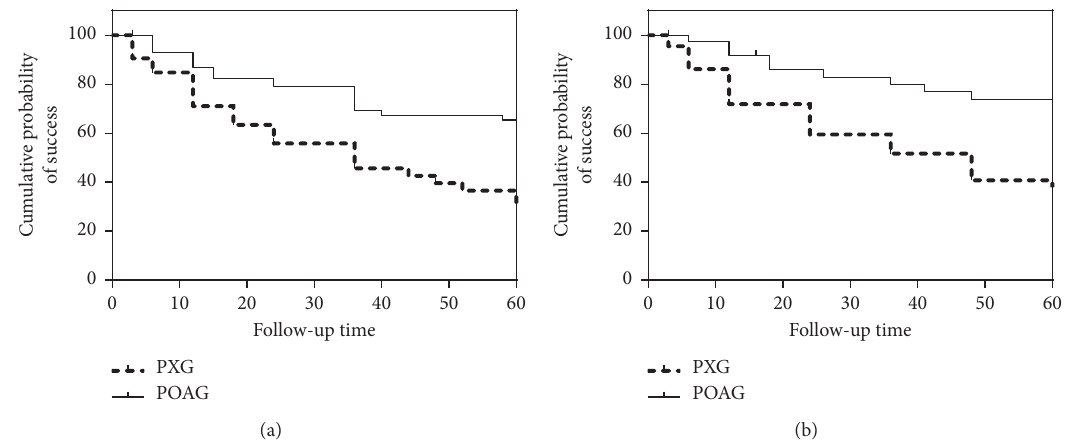
Figure 1: Kaplan–Meier survival analysis of complete (a) and qualified (b) success of trabeculectomy in patients according to criterion A in the PXG and POAG groups. Complete and qualified success rates were significantly different in the PXG and POAG groups ( P � 0 . 001, P � 0 . 007, Mantel–Cox log-rank test, and criterion A).